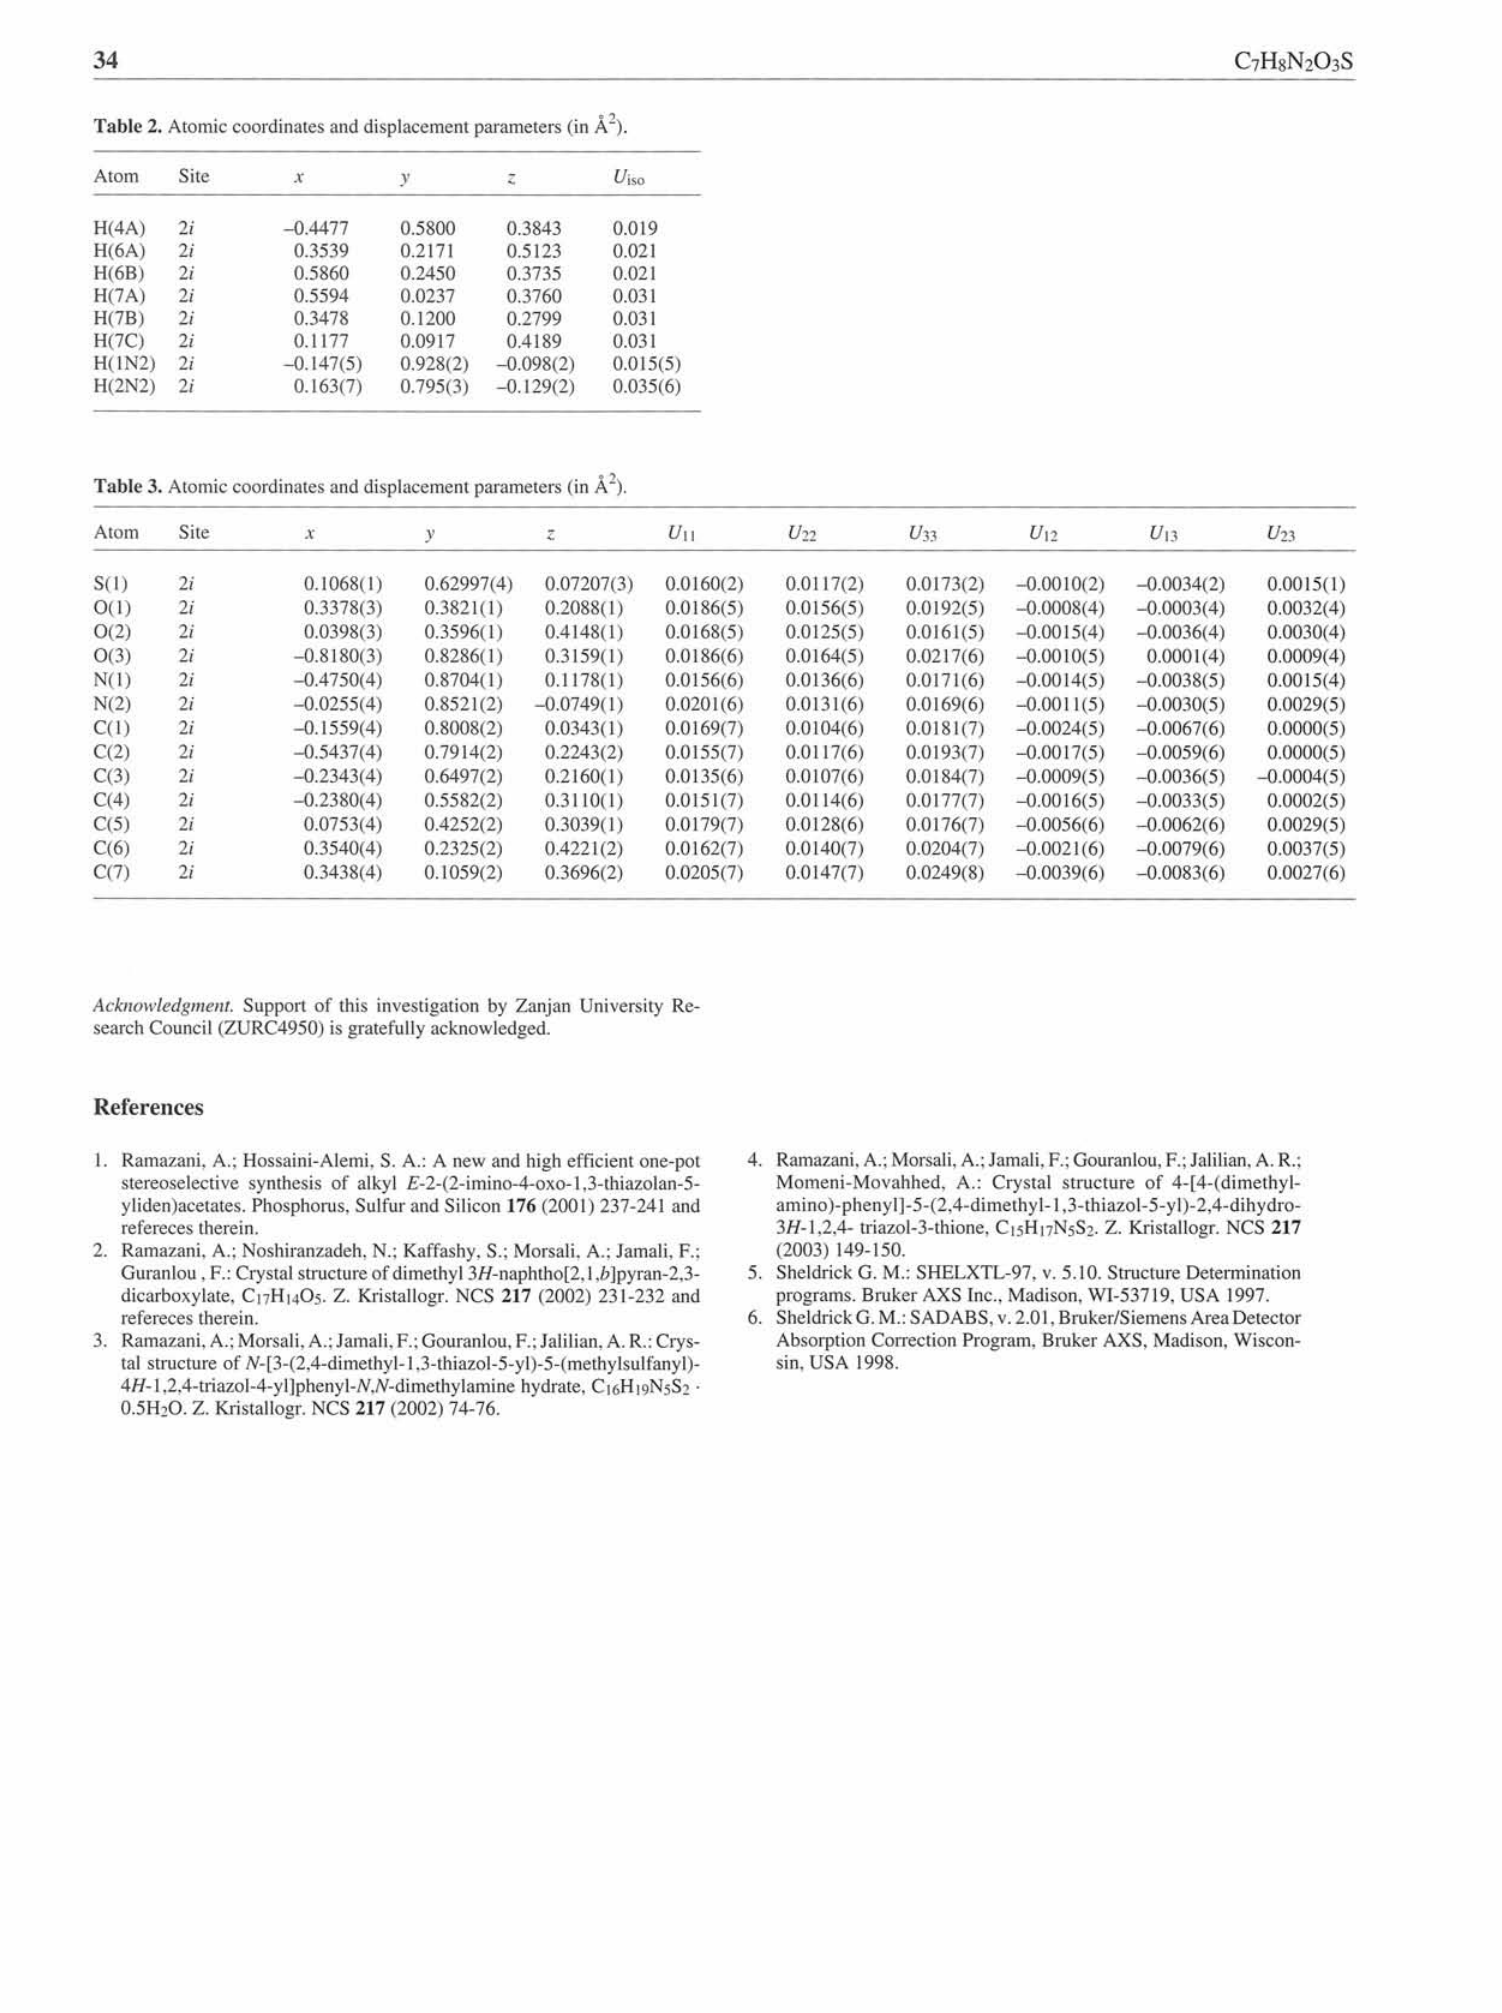
Table 2. Atomic coordinates and displacement parameters (in À 2 ).